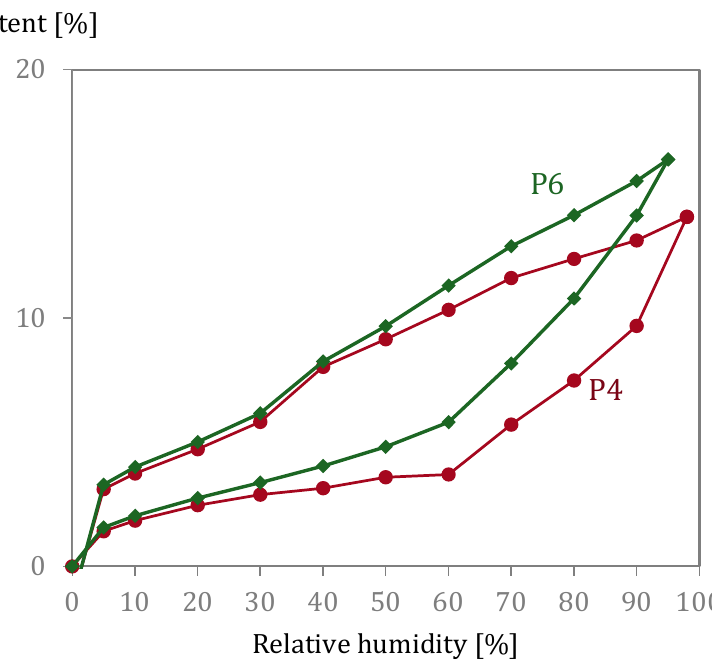
Figure 7. Sorption isotherms (DVS) of P4 (pink rounded markers) and P6 (green rhomboidal markers).